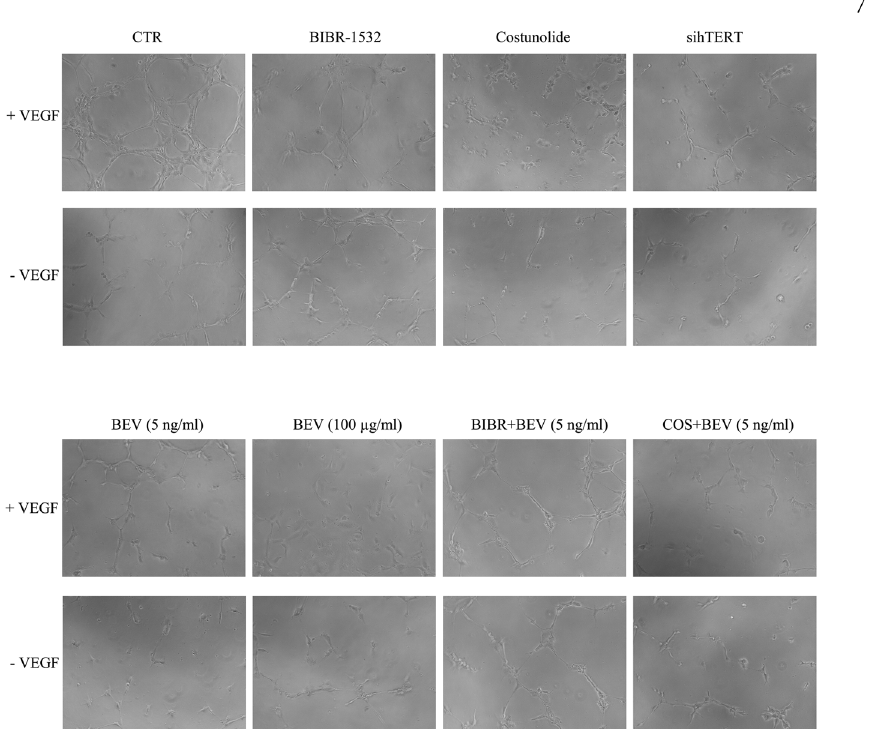
Fig 7. Telomerase regulatestube formation by HUVECs. HUVECspreviouslytreatedwith BIBR-1532 (10 μ M),costunolide (10 μ M),bevacizumab (5 ng/mlor 100 μ g/ml),or hTERTsiRNAwereculturedon an extracellular matrix(ECM) in the presenceor absenceof recombinantVEGF165(50ng/ml). Angiogenesis began after 4 hours,andtube formation was thenvisualizedafter 6 hours,usingan inverted microscope(100X).